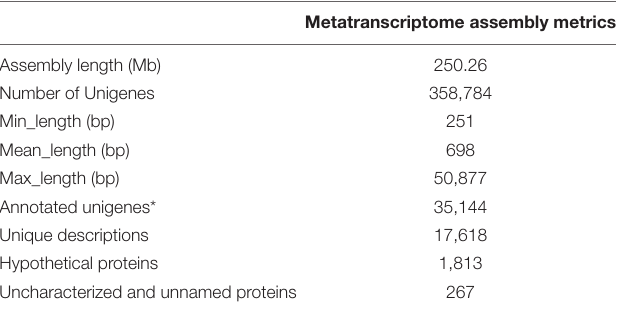
TABLE 1 | Metrics of the metatranscriptome reconstruction.